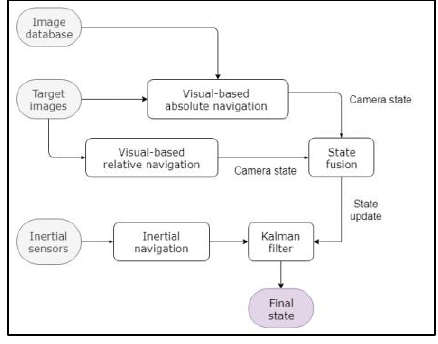
Figure 1. Integrated Navigation System